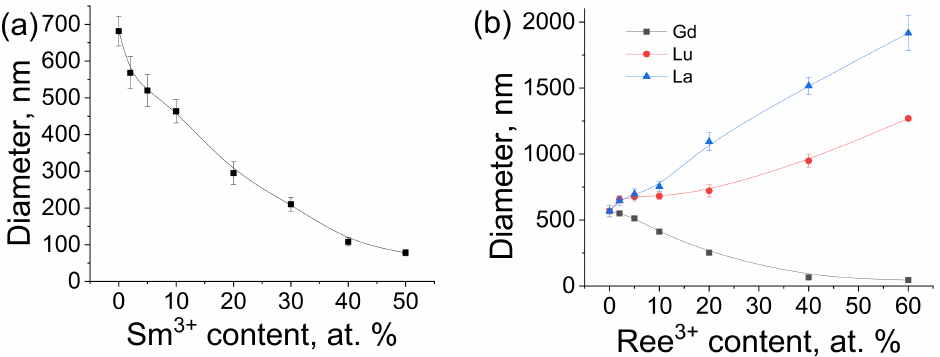
Figure 7. The effect of dopant nature and concentration on NaY 1 − x Sm x F 4 ( a ) NaY 0.98 − x Sm 0.02 Ln x F 4 ( b ) particle